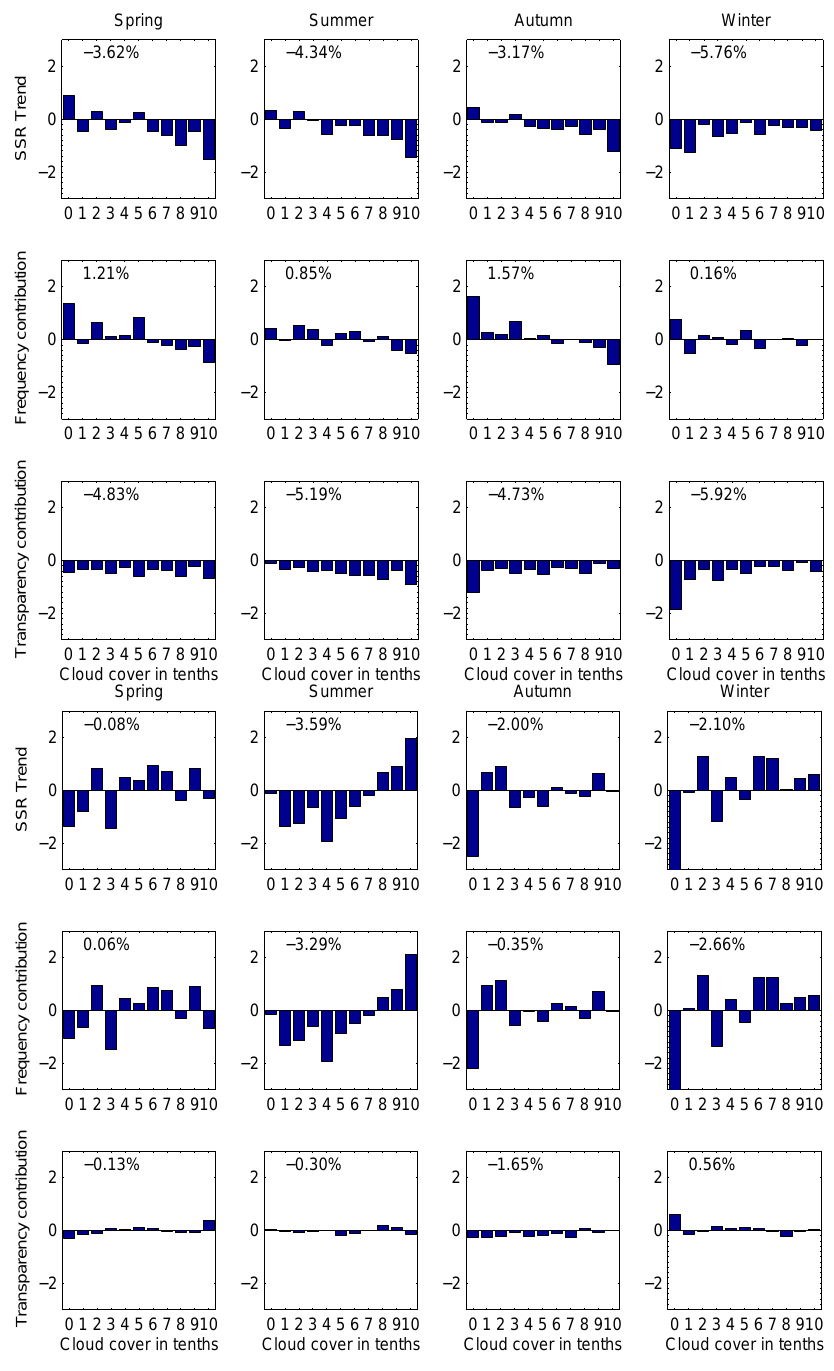
Fig. 7. The same as in Fig. 6, but in Northeast